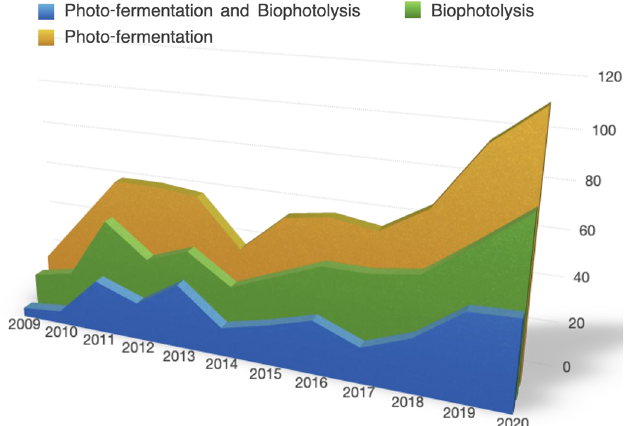
Fig. 3. 3D presentation of the year-by-year analysis of literature search